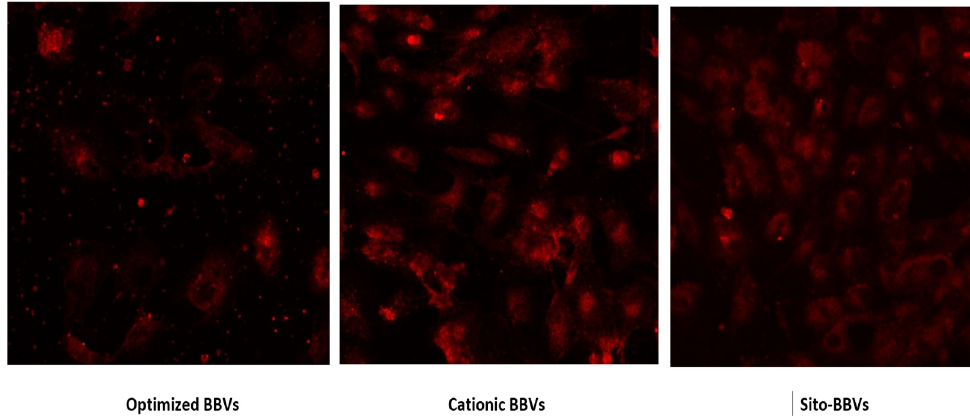
Fig 5. Confocal laser scanning microscopy (CLSM) images of HepG2 cells after incubation with Rh B labelled BBVs for 2 h at 37˚C. (a) ABBVs, (b) CBBVs and (c) Sito-GBBVs.